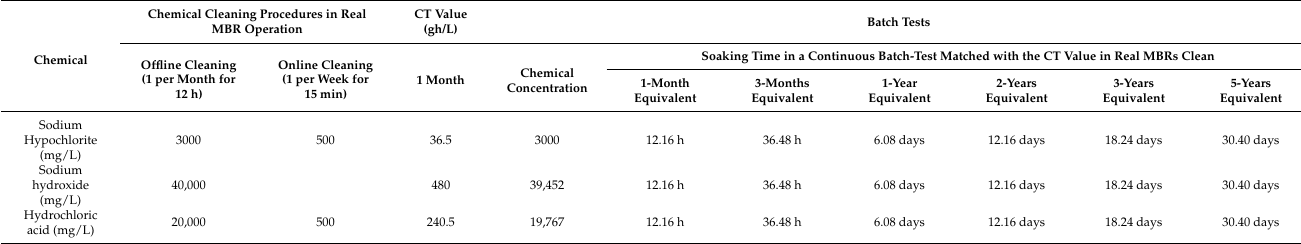
Table 3. Calculation of CT values of cleaning frequency, cleaning duration, and chemical